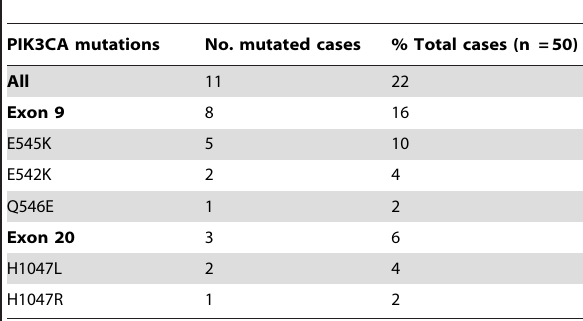
Table 1. Results of PIK3CA